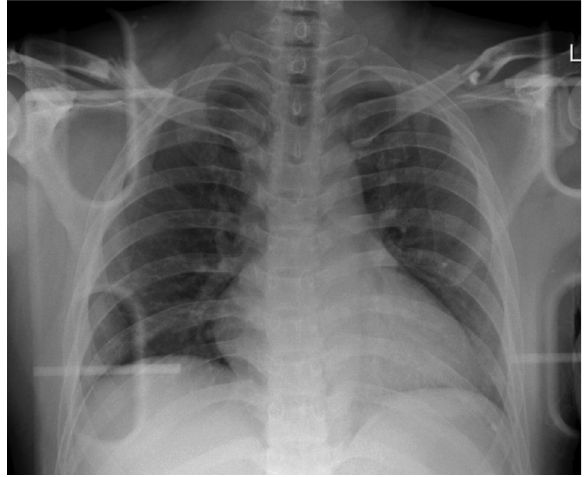
Radiographs immediate post-operation showed Fig. 1b: 3.5mm reconstruction plate used to fix the